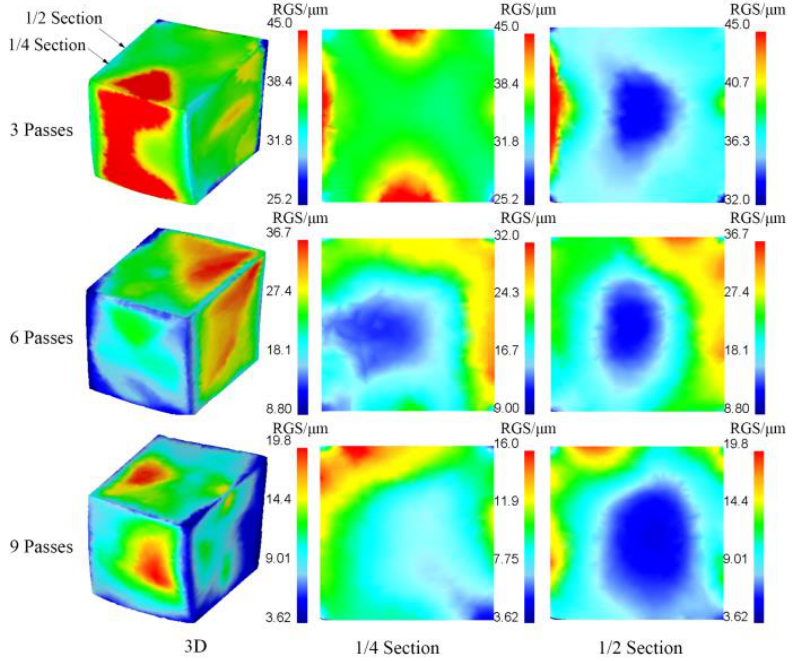
Figure 7. Cloud diagram for different grain size distributions for double-open MDF at 800 °C.